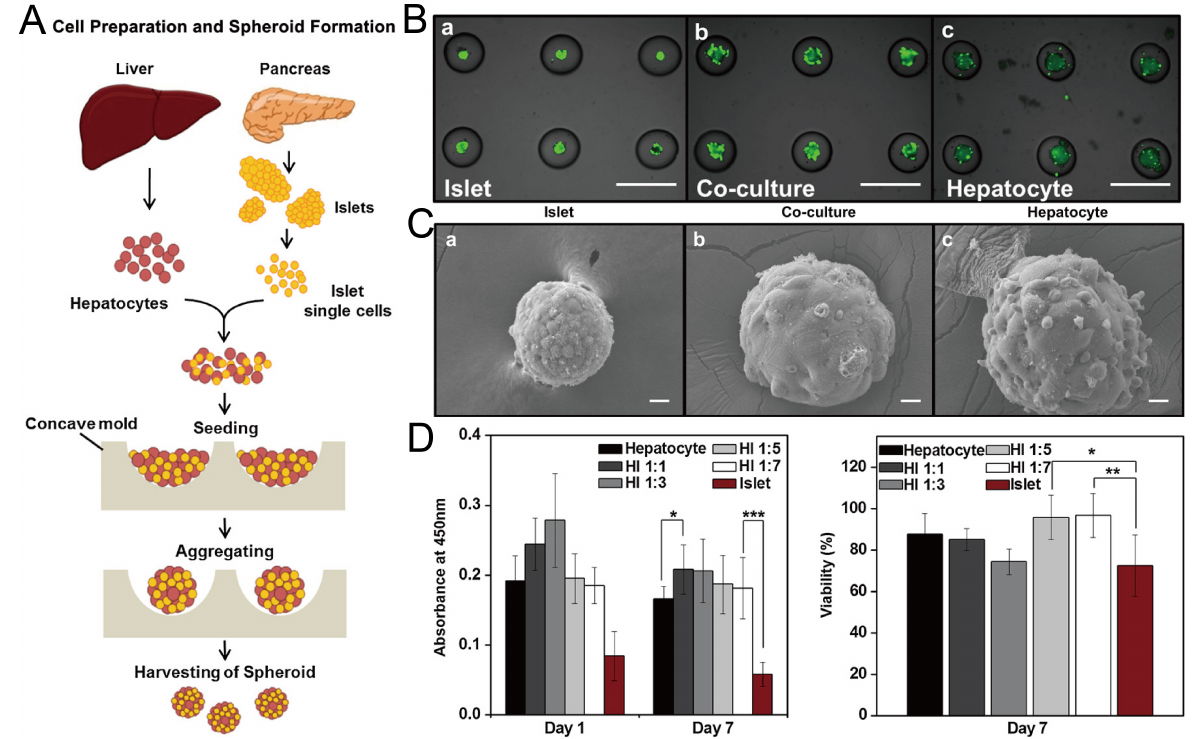
Figure 19. Formation of hybrid spheroids by culturing hepatocytes and islet single cells together [97]. ( A ) The schematic view of the formation of hybrid spheroids by hepatocytes and islet single cells. ( B ) Pictures of mono-culture of islet single cells (left), hepatocytes (right) and co-culture of islet single cells and hepatocytes (middle), in which the green fluorescence indicates the live cells. Scale bars: 500 µm. ( C ) SEM pictures of spheroids of mono-culture of islet single cells (left), hepatocytes (right) and co-culture of islet single cells and hepatocytes (middle). Scale bars: 20 µm. ( D ) Results of Cell Counting Kit-8 (CCK-8) applied to spheroids with different mixing ratios of hepatocytes and islet single cells on day 1 and day 7 (left), and normalized viability of cells in different spheroids on day 7 versus day 1 (right). * p < 0.05, ** p < 0.01, *** p < 0.001. Reprinted (adapted) from [97]. Copyright (2013) with permission from